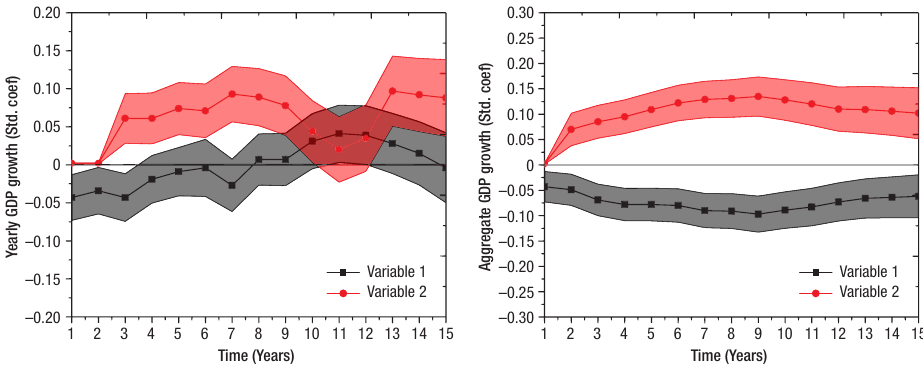
Fig. 3. Relation between the time scale and the standardized coefficients for the composite variables Notes: composite variables represent the trade cycles for category SIC 4. Shaded areas depict a 95% confidence